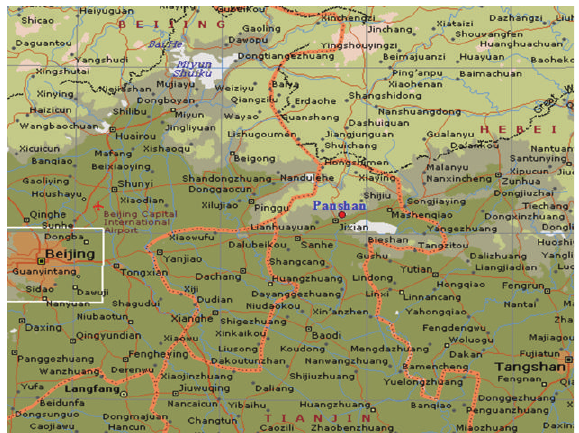
Figure 1: The map of the project location–Panshan Power